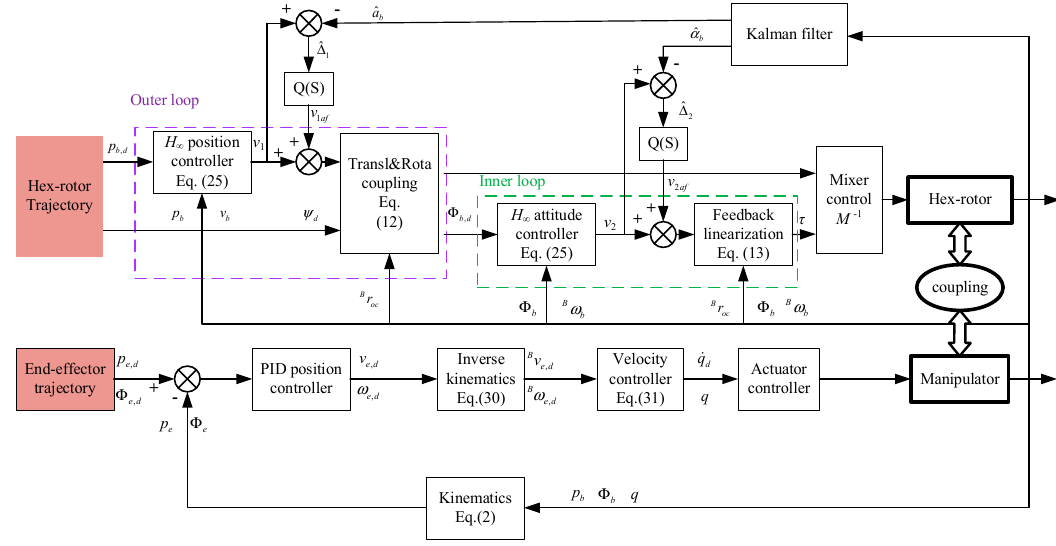
Figure 3. Control structure of the aerial manipulator system.